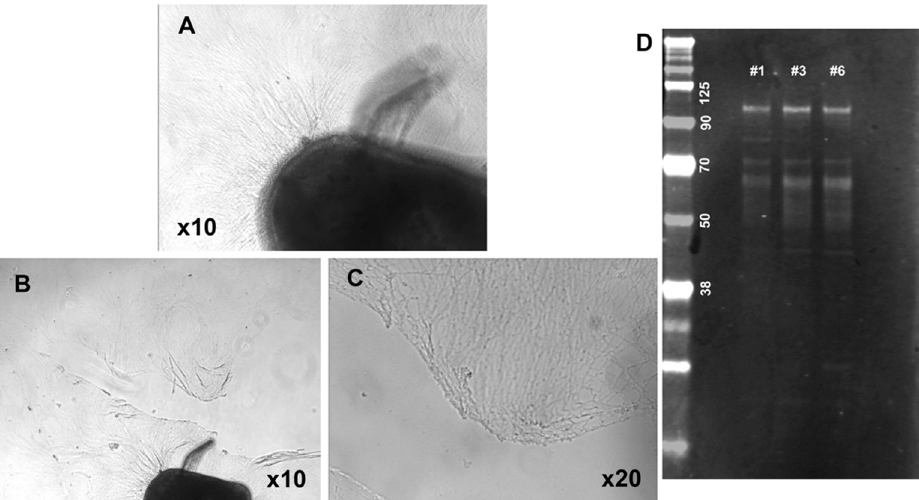
Figure 8. Characterization of SCG explants (P3) cultured for 8 days and lesioned. Phase contrast images show the network of neurites growing around the explant ( A ). They were lesioned at about half of their length ( B , C ) and shown at low ( B ) and high ( C ) magnification immediately after the lesion, then allowed to regrow (Figures 9 and 10). Western blot stained with the 3 ′ tau antibodies show Big tau expression at 110 kDa ( D ) in the P3 explants grown for 8 days, which were lesioned and cultured overnight (lanes #1 and #3) with lane #6 showing the explant without the lesion.